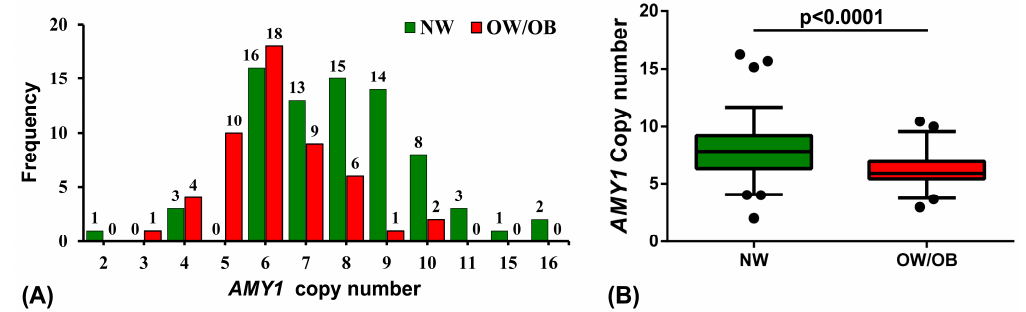
Figure 1. The AMY1 copy number in the study population. ( A ) Distribution of AMY1 copy number in the study population. The copy number of AMY1 was rounded to nearest integer. ( B ) Mean AMY1 copy number in normal weight (NW) and overweight/obese (OW/OB) participants ( p < 0.0001).